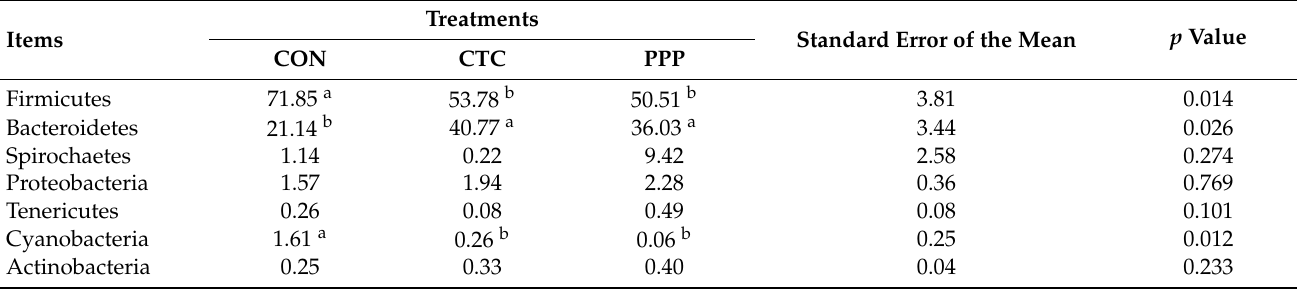
Table 6. The relative abundance of colonic microflora at phylum level (%).